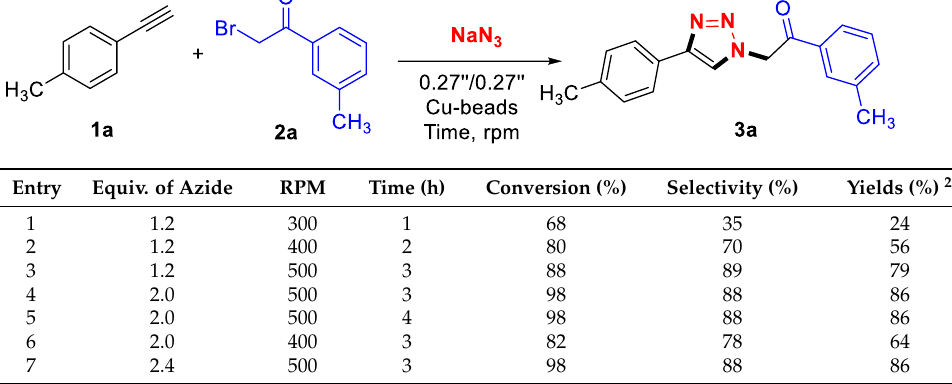
Table 1. Mechanochemical optimization of reaction parameters 1 .